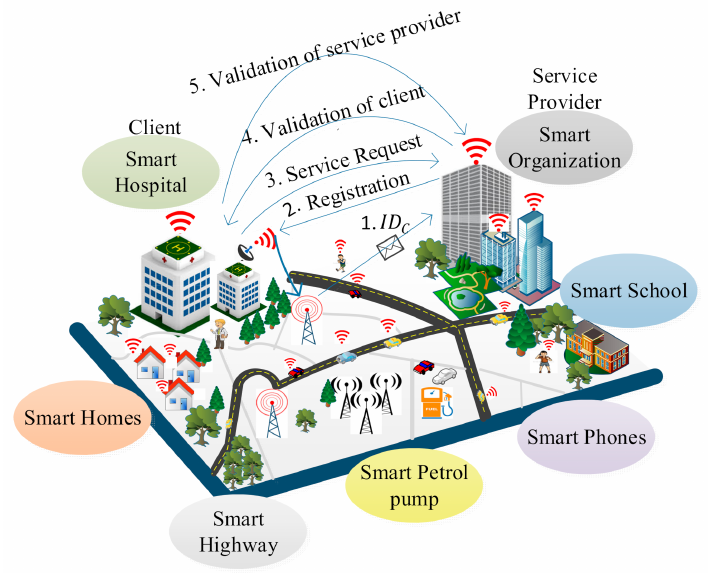
Figure 1. A system model for the lightweight postquantum ID-based signature (LPQS)